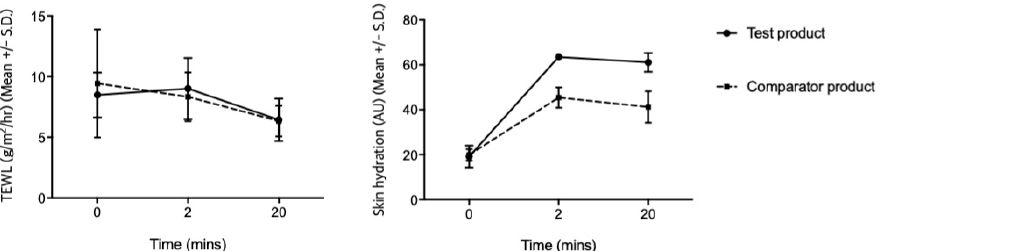
Figure 3. Characterization of N -palmitoyl serinol. ( A ) Activation of CB1R by tested compounds were measured using cAMP Hunter™ eXpress CNR1 (CB1) CHO-K1 GPCR Assay (Eurofins DiscoverX